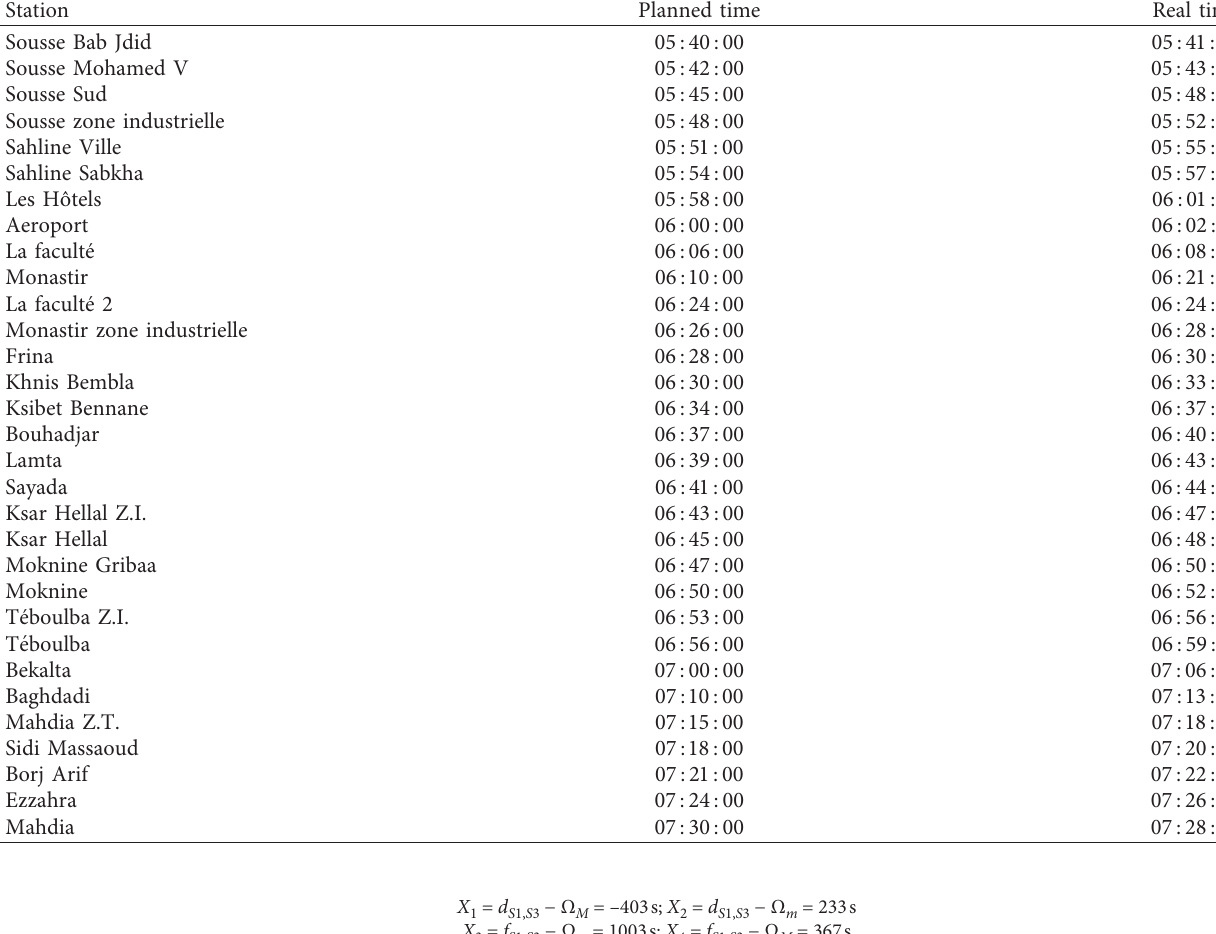
Table 3: Planned and measured times: Sousse to Mahdia